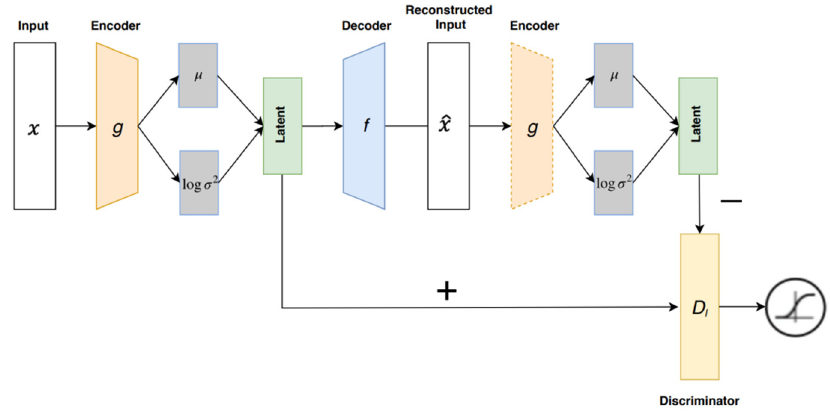
Figure 5. Architecture of the extended variational autoencoder (VAE), which is based on the VAE architecture, with the addition of a discriminator D l . The dotted encoder is not updated during the training.